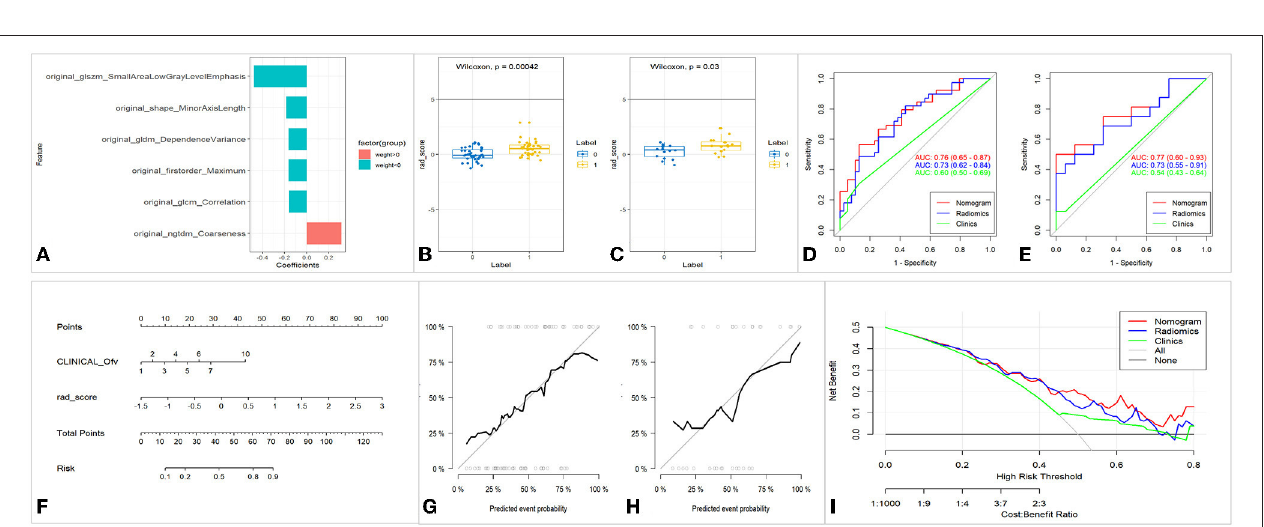
FIGURE 3 | The feature selection of UC-ITN ROI without NVC on the unaffected side and its difference test. (A) Wilcoxon’s test of the rad_score between the two groups of trigeminal-nerve cisternal segment feature selection and importance ratio. (B,C) Wilcoxon’s test of rad_score in the training and validation cohorts. UC-ITN, unilateral classical Trigeminal neuralgia; ROI, region of interest; NVC, neurovascular compression.